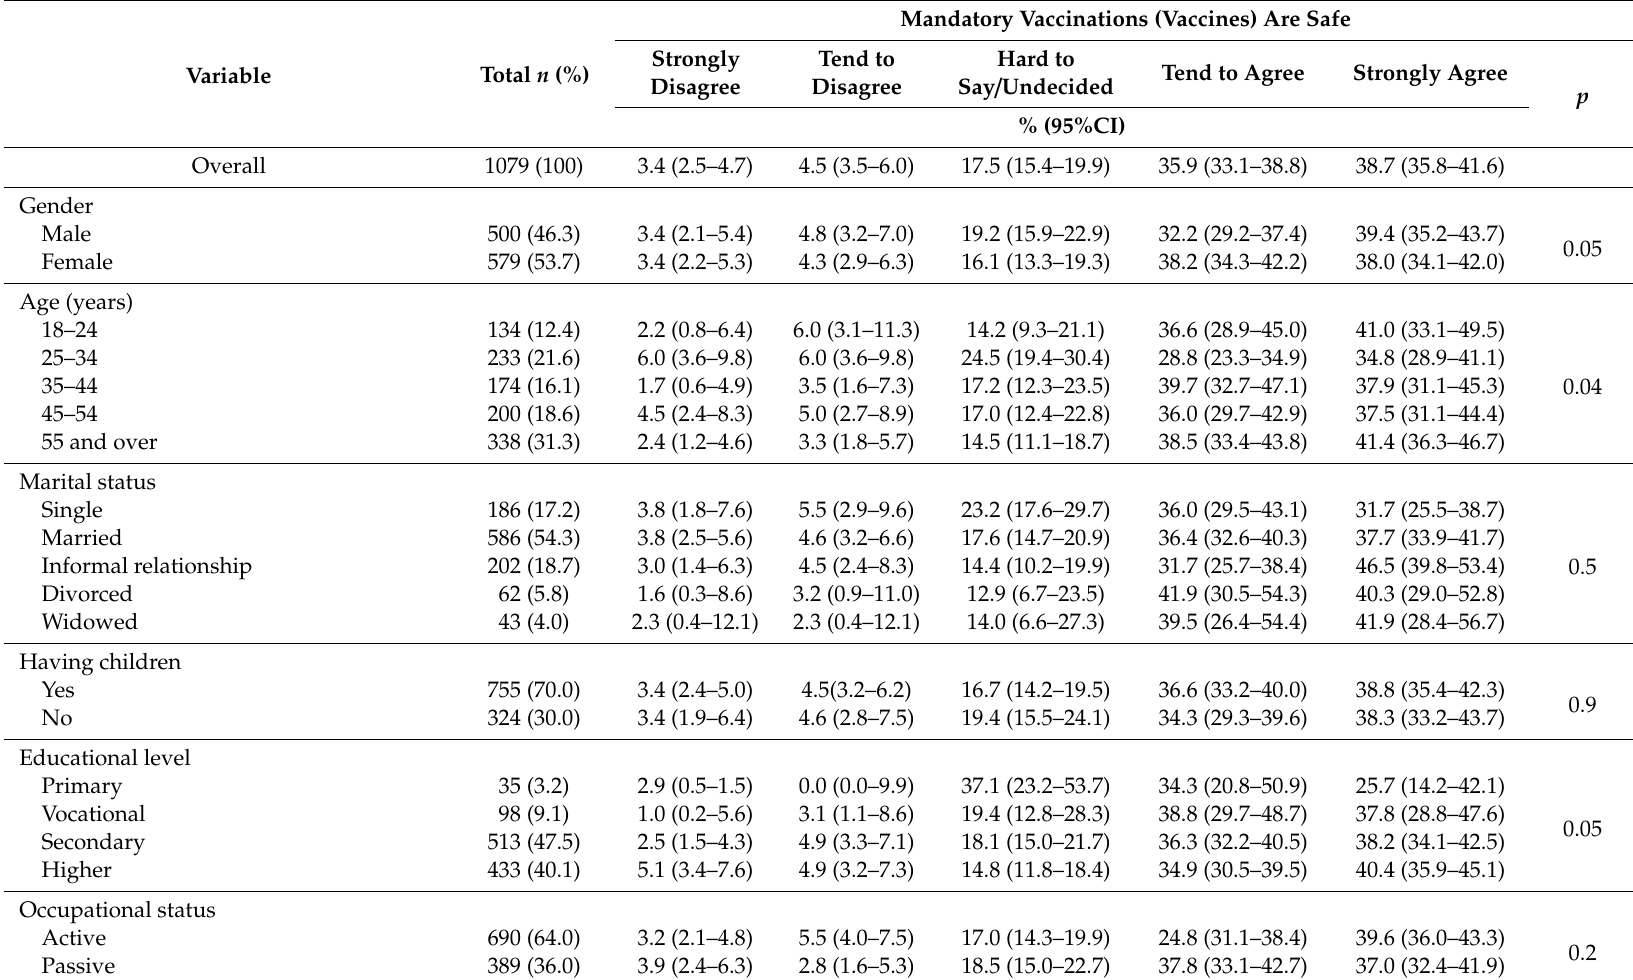
Table 1. Structure of the study participants by state of vaccine confidence ( n =